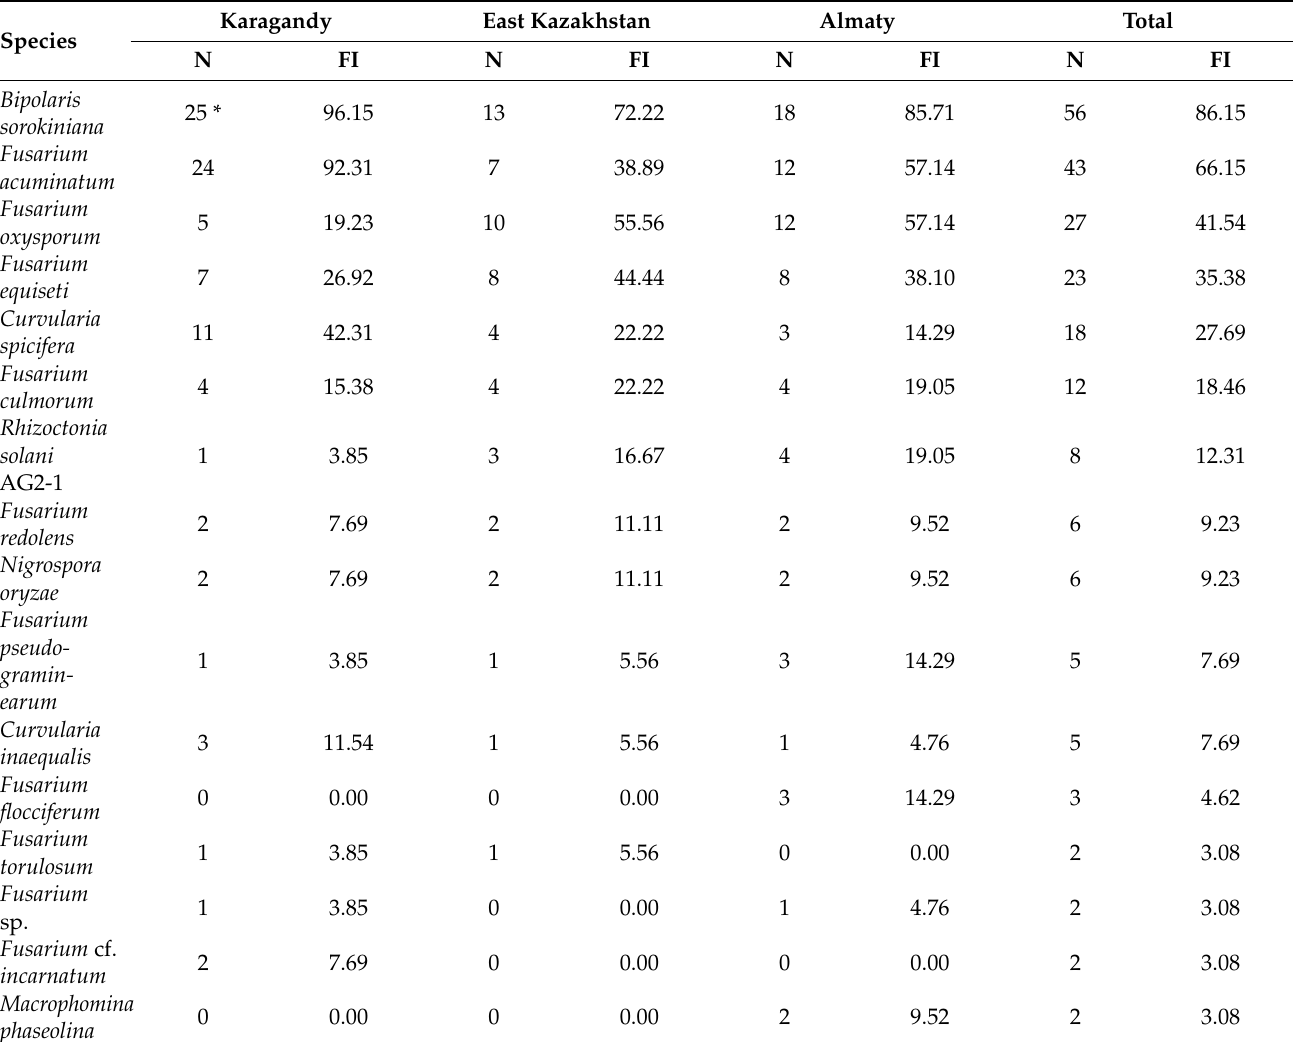
Table 2. The distribution of fungal species associated with wheat crown/root rot and field incidence of fungal species across three different wheat-growing regions in